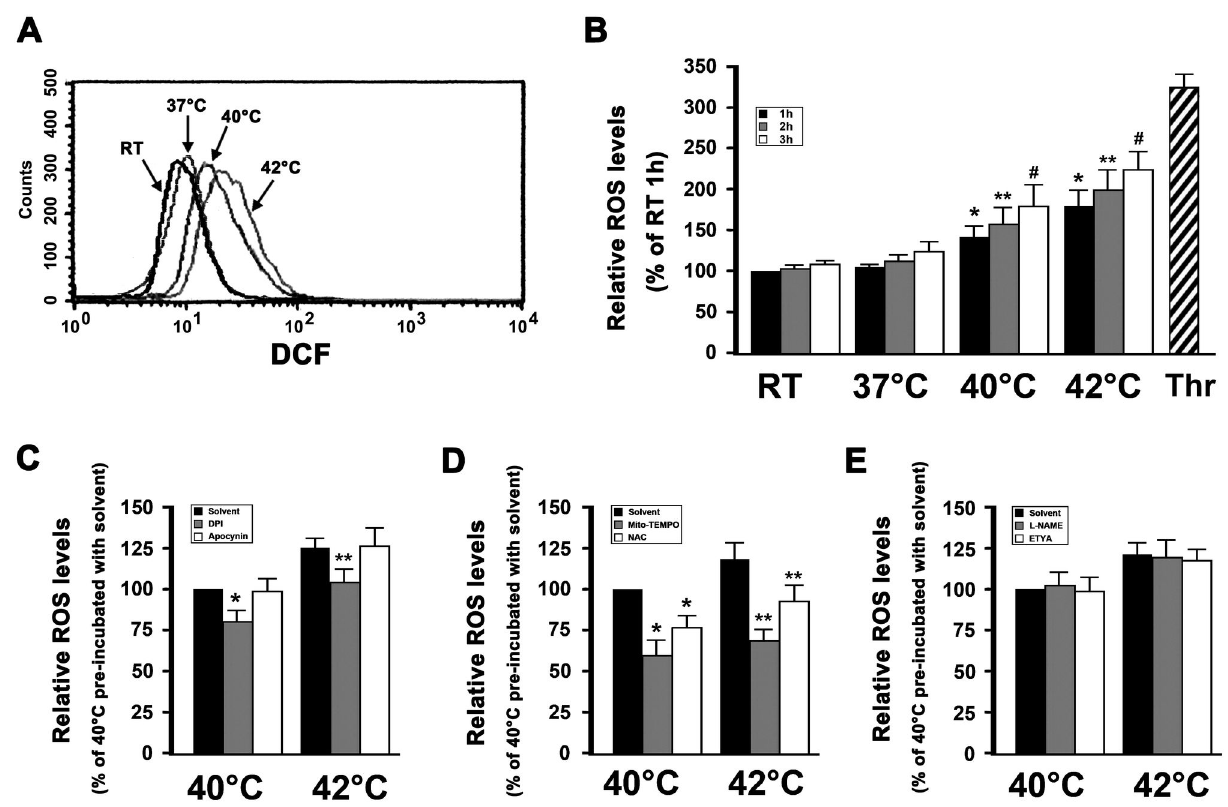
Figure 1. Mitochondria are the major sources of ROS in hyperthermia-treated platelets. (A and B) DCFDA-loaded platelets were incubated at the indicated temperatures for 3 h (A) or 1-3 h (B). As a positive control, loaded platelets were incubated with thrombin at 37°C for 30 min. Samples were then analyzed for intracellular ROS levels by flow cytometry. Representative flow cytometric histogram is shown (A). The relative ROS levels are expressed as a percentage of platelets, which were incubated at RT for 1 h (B). Percentage of RT 1h is presented as mean ± SEM from three independent experiments. * P <0.017 (after Bonferroni correction) as compared with RT 1 h, ** P <0.017 (after Bonferroni correction) as compared with RT 2 h, # P <0.017 (after Bonferroni correction) as compared with RT 3h. (C–E) DCFDA-loaded platelets were pre-incubated with solvent control, DPI and apocynin (C), Mito-TEMPO and NAC (D), or L-NAME and ETYA (E) at 37 °C for 15 min, and then incubated for 3 h at 40°C or 42°C, and further analyzed by flow cytometry. The relative ROS levels are expressed as a percentage of platelets, which were pre-incubated with solvent control at 37°C for 15 min and then incubated at 40°C for 3 h. Percentage of 40°C loaded platelets pre-incubated with solvent control is presented as mean ± SEM from three independent experiments. * P <0.025 (after Bonferroni correction) as compared with solvent control at 40°C, ** P <0.025 (after Bonferroni correction) as compared with solvent control at 42°C. Thrombin is labeled as